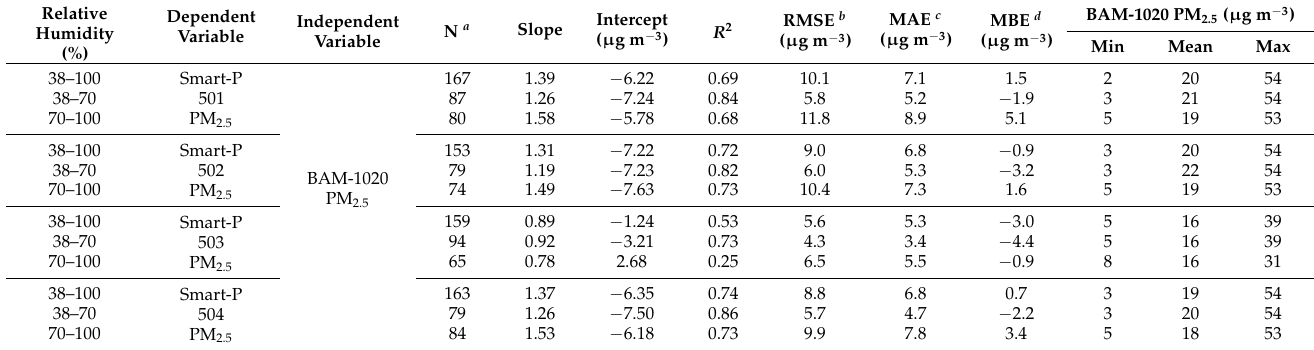
Table 1. Summary of linear regression models of hourly average PM 2.5 concentrations